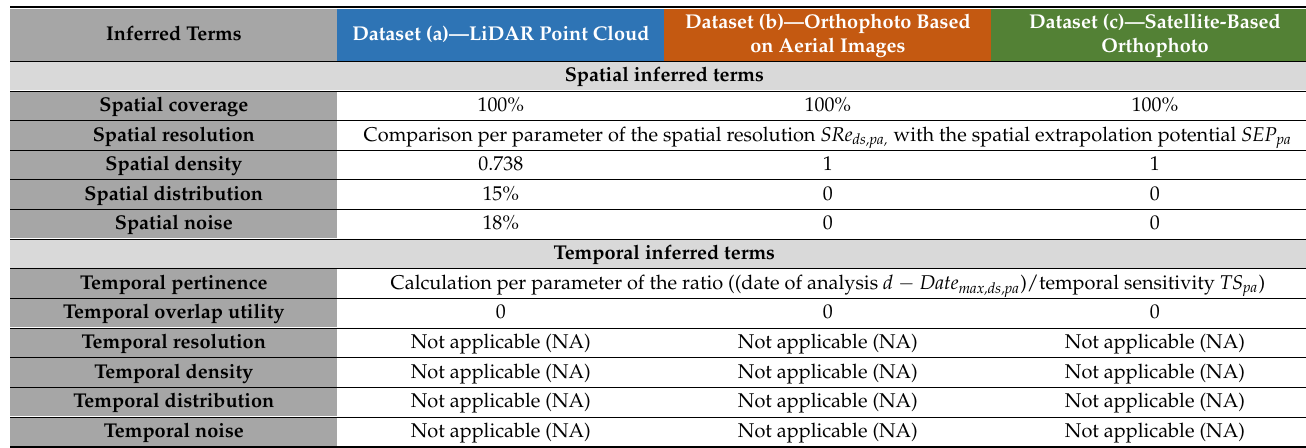
Table 21. Inferred scene-related DC